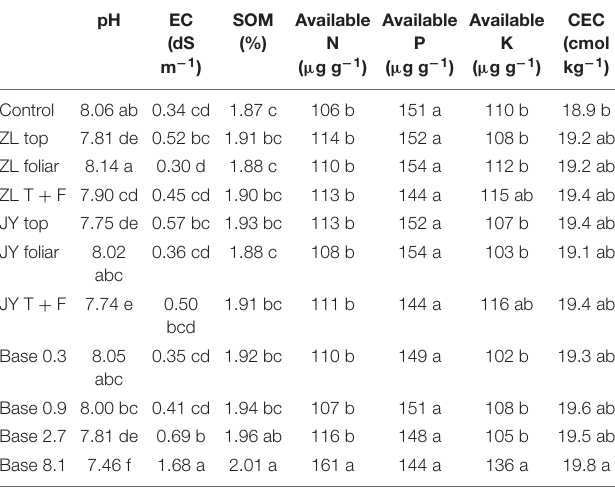
TABLE 6 | The effect of fulvic acids on the properties of soils where tomato plants cv. Hezuo906 were grown for 126 days from transplanting (Experiment 1). pH EC SOM Available Available Available CEC (dS (%) N P K (cmol m − 1 ) ( µ g g − 1 ) ( µ g g − 1 ) ( µ g g − 1 ) kg − 1